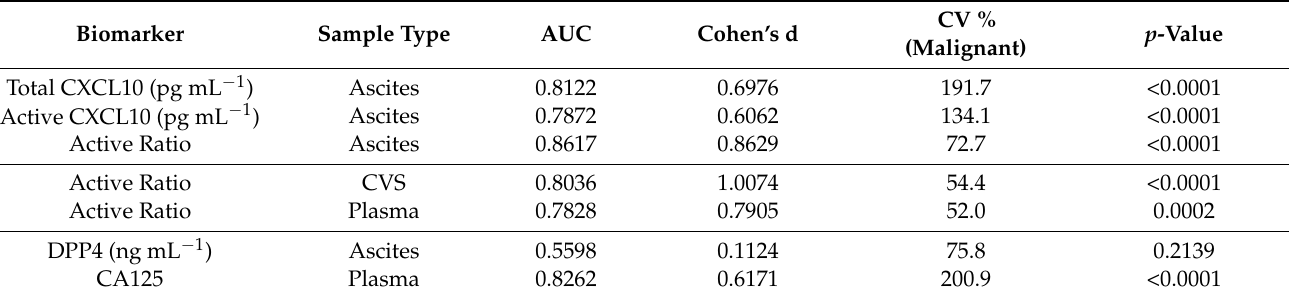
Figure 7. Marker combinations using ART discriminate between benign and malignant disease. Receiver operator curves (ROC) were used to evaluate the discriminatory power of ART alone compared with ( A ) individual measurements of total or active CXCL10; or ( B ) CA125 alone, DPP4 alone or a combination of CA125, DPP4 and ART in ascites samples. Table 4. Effect sizes of biomarkers based on sample